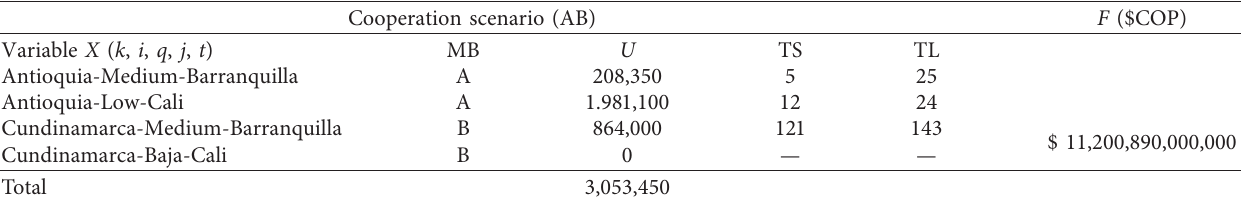
Table 3: Results of the programming model under scenario 2.